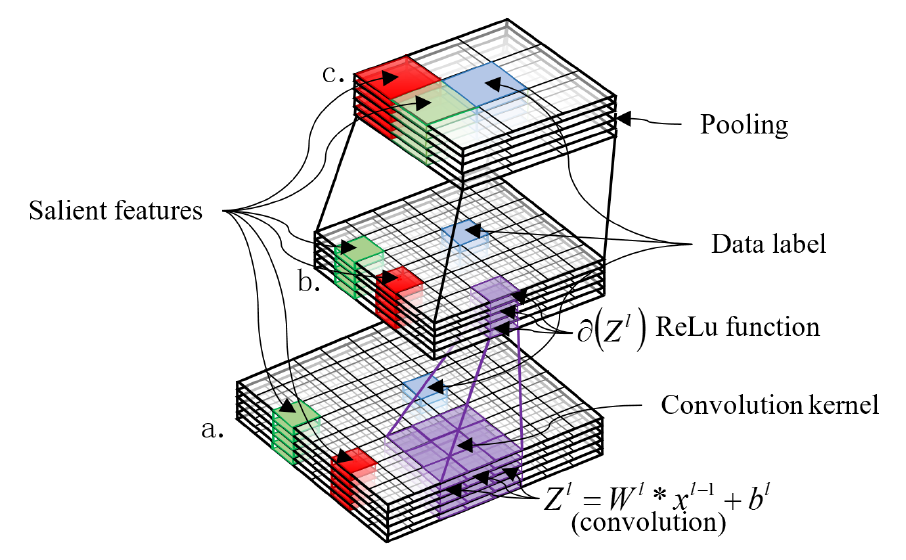
Figure 1. The processing of feature extraction in deep convolution neural network